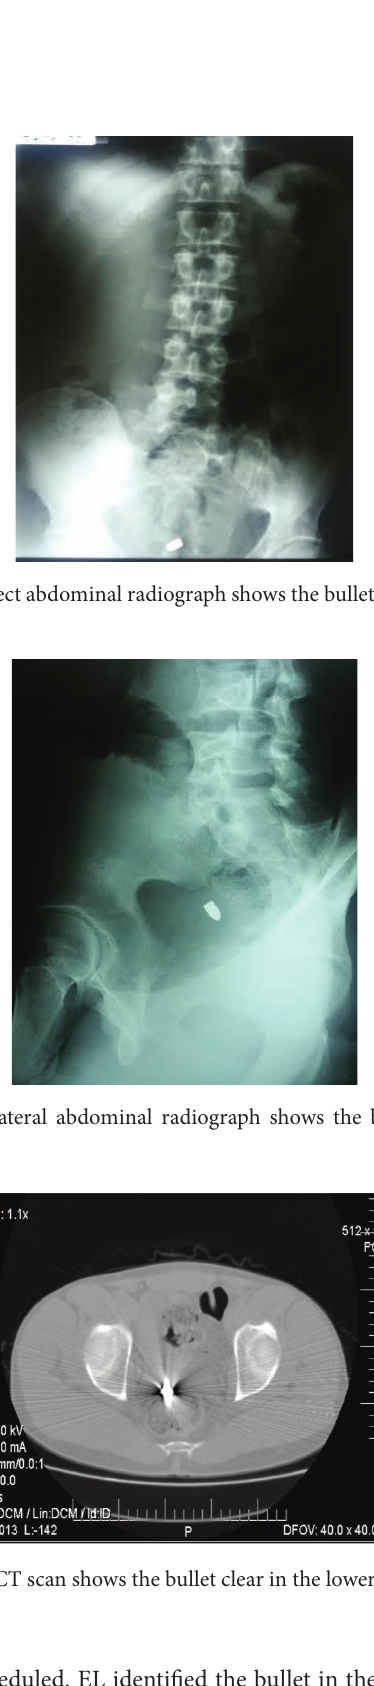
EL was scheduled. EL identified the bullet in the peritoneal cavity, with no other damages. Finally, the bullet was removed laparoscopically (Figure 4). The patient remained for 24 hours in the surgical department and was discharged from hospital in good conditions.